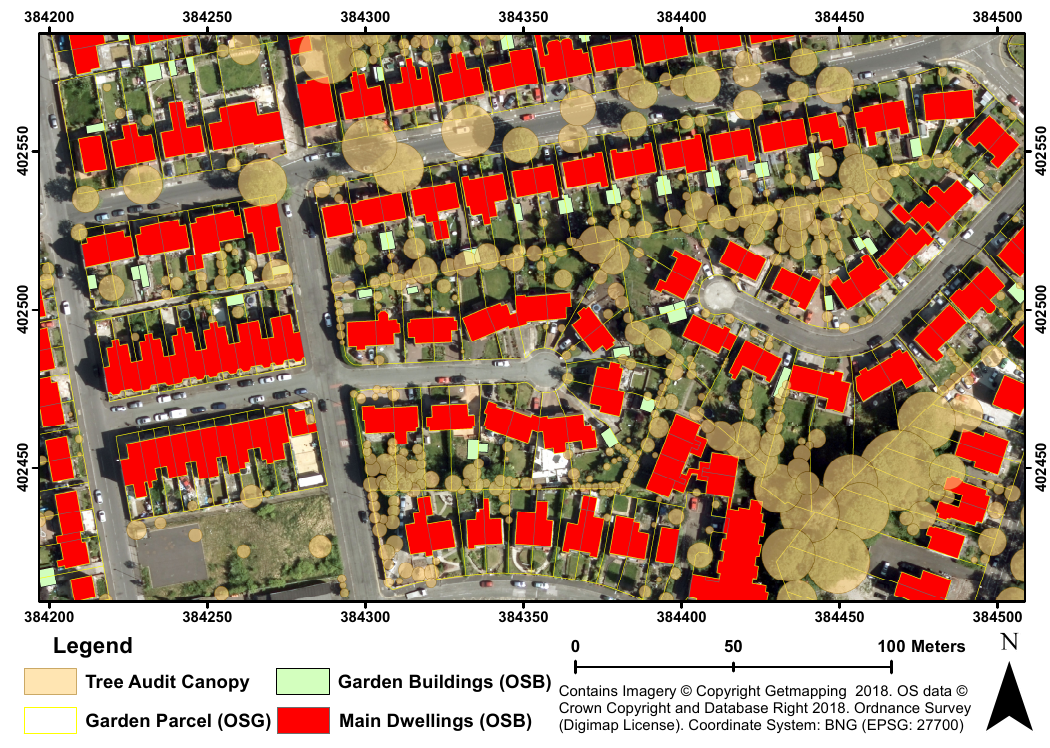
Figure 3. Geospatial datasets used in the image